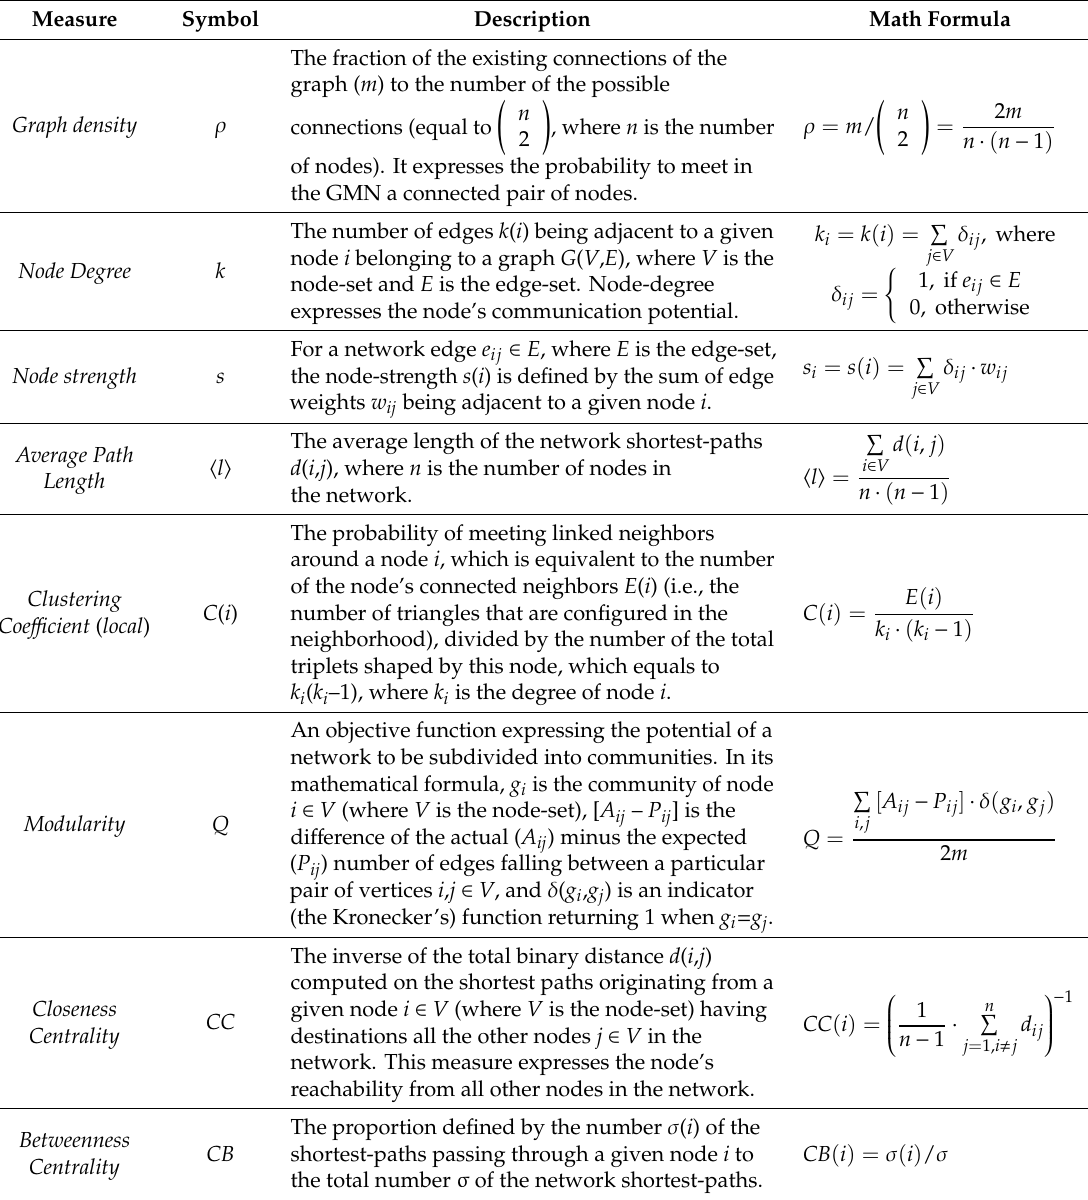
Table 1. Network measures ( * ) used in the